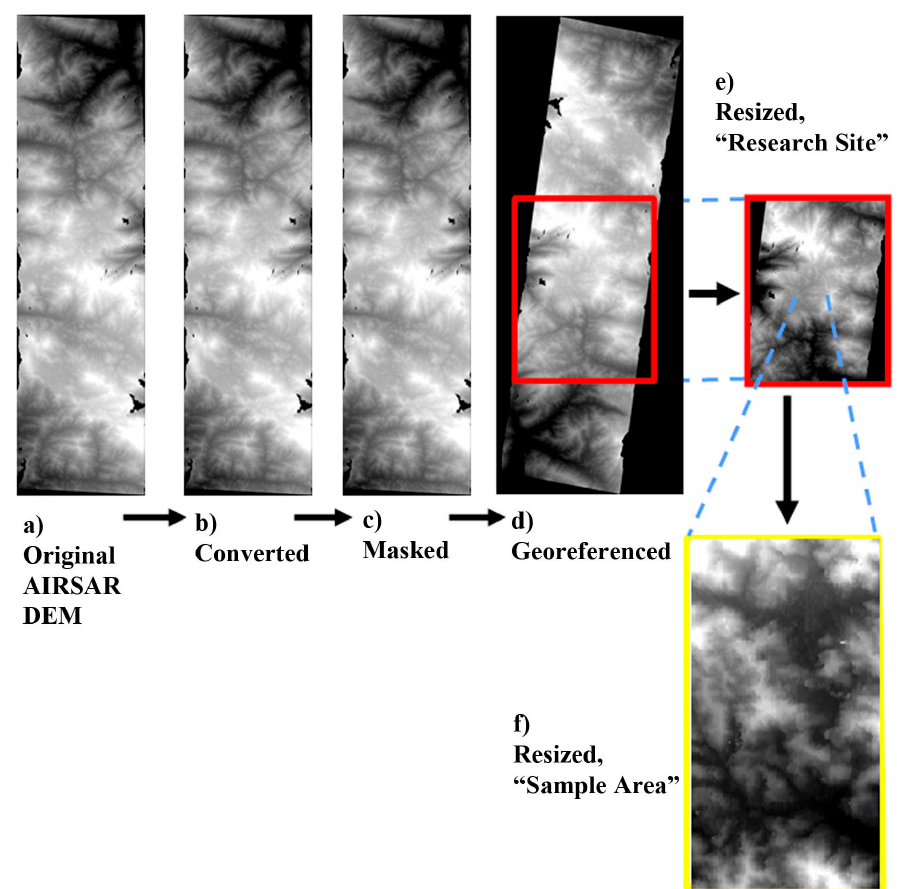
Figure 4. Sequence of the AIRSAR DEM process: ( a ) opened C-band DEM, ( b ) converted DEM to actual height values, ( c ) masked DEM image, ( d ) geo-referenced, ( e ) resized DEM to the size of research site and ( f ) resized sample